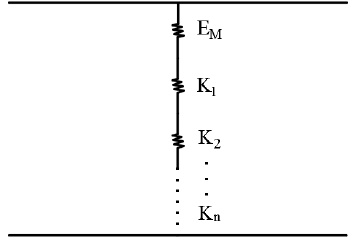
Figure 3. Downgraded stiffness for the equivalent continua.